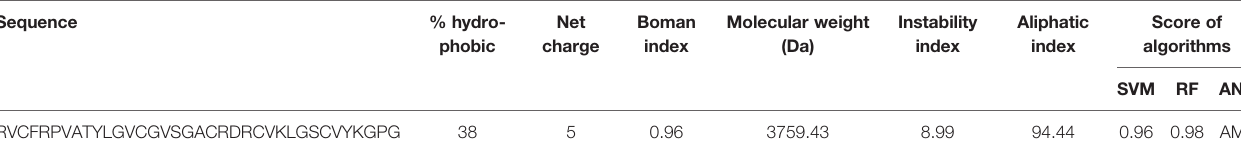
TABLE 2 | The probability of antimicrobial activity and physicochemical features of Cc-AFP1.